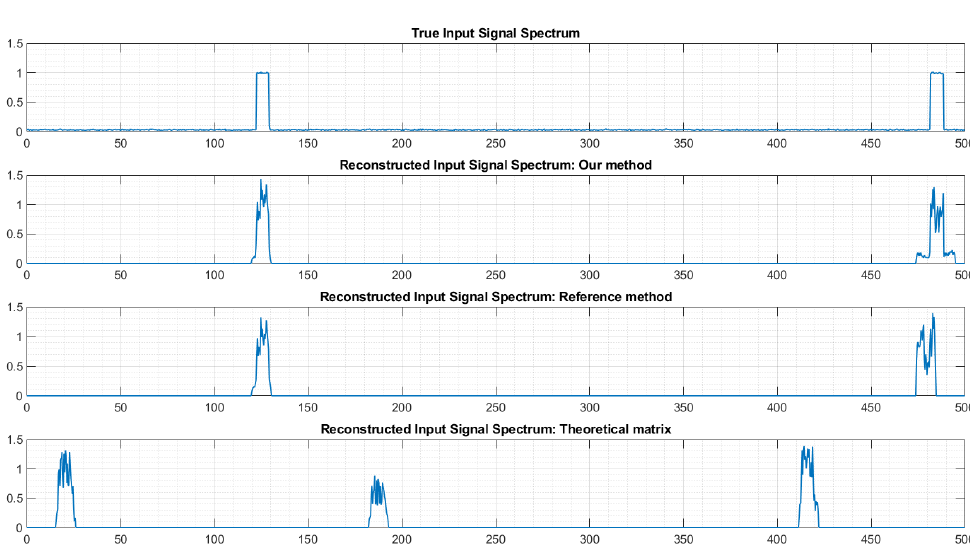
Figure 20. Example of spectrum reconstruction with 2 transmitters. The horizontal axes are frequen- cies, labeled in MHz.